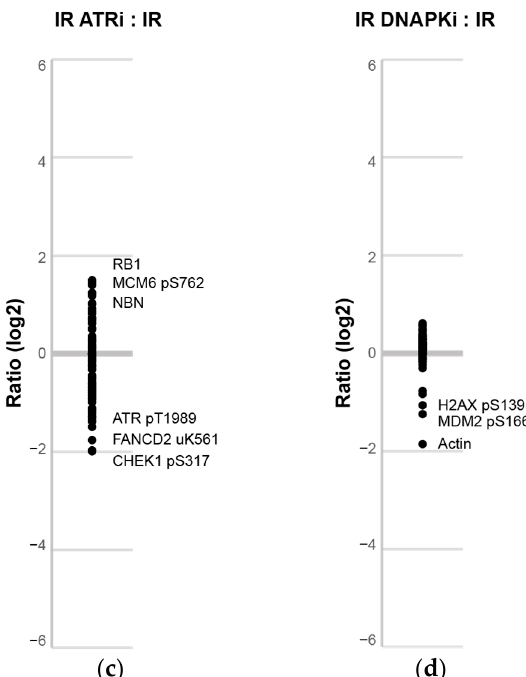
Figure 5. Pharmacodynamic markers of kinase inhibition identified by comparing protein and phosphorylation levels in PBMCs. The ratio of concentration levels in PBMCs (SEB+) determined by the immuno-MRM assay is plotted for four comparisons: ( a ) 5 Gy versus mock-irradiation, ( b ) irradiated in the presence of ATM inhibitor versus vehicle (DMSO), ( c ) irradiated in the presence of ATR inhibitor versus vehicle (DMSO), and ( d ) irradiated in the presence of DNAPK inhibitor versus vehicle (DMSO). The log(2) ratio is plotted for each comparison. Large changes are labeled with the analyte and phosphorylation site (if